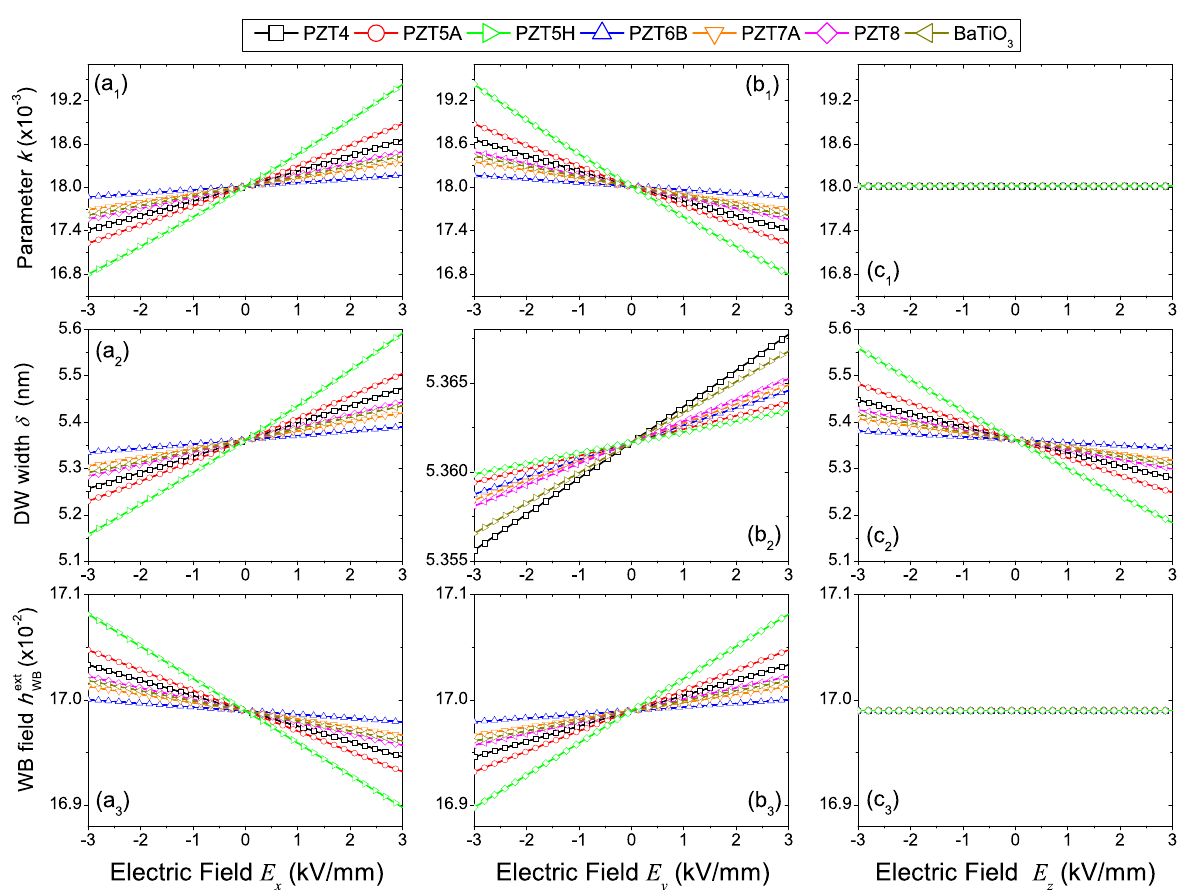
Figure 2. Electric-field dependence of parameter k (top panels), DW width δ (middle panels) and WB field h ext panels) in the three proposed configurations: ( a 1 – a 3 ) E// Π //e x , ( b 1 – b 3 ) E// Π //e y and (c 1 ,c 2 ,c 3 ) E// Π //e z , for the seven ceramic PZ materials taken into account (depicted in the top